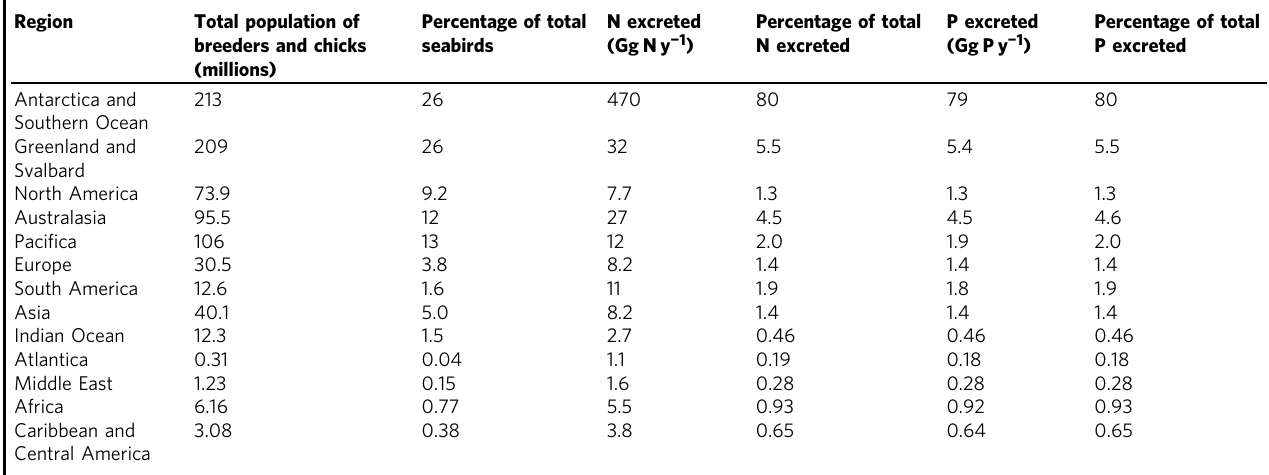
Table 2 Biogeographic distribution of total N and P excreted by seabird breeders and chicks